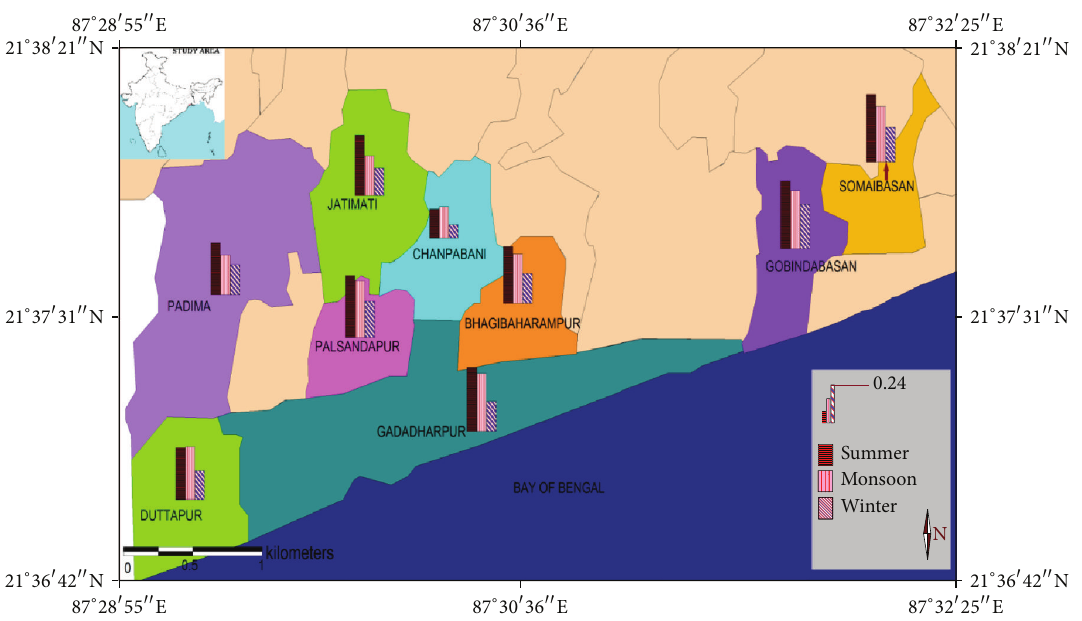
Figure 1: GIS image of the study site showing seasonal diversity of Bacillus spp. in bar